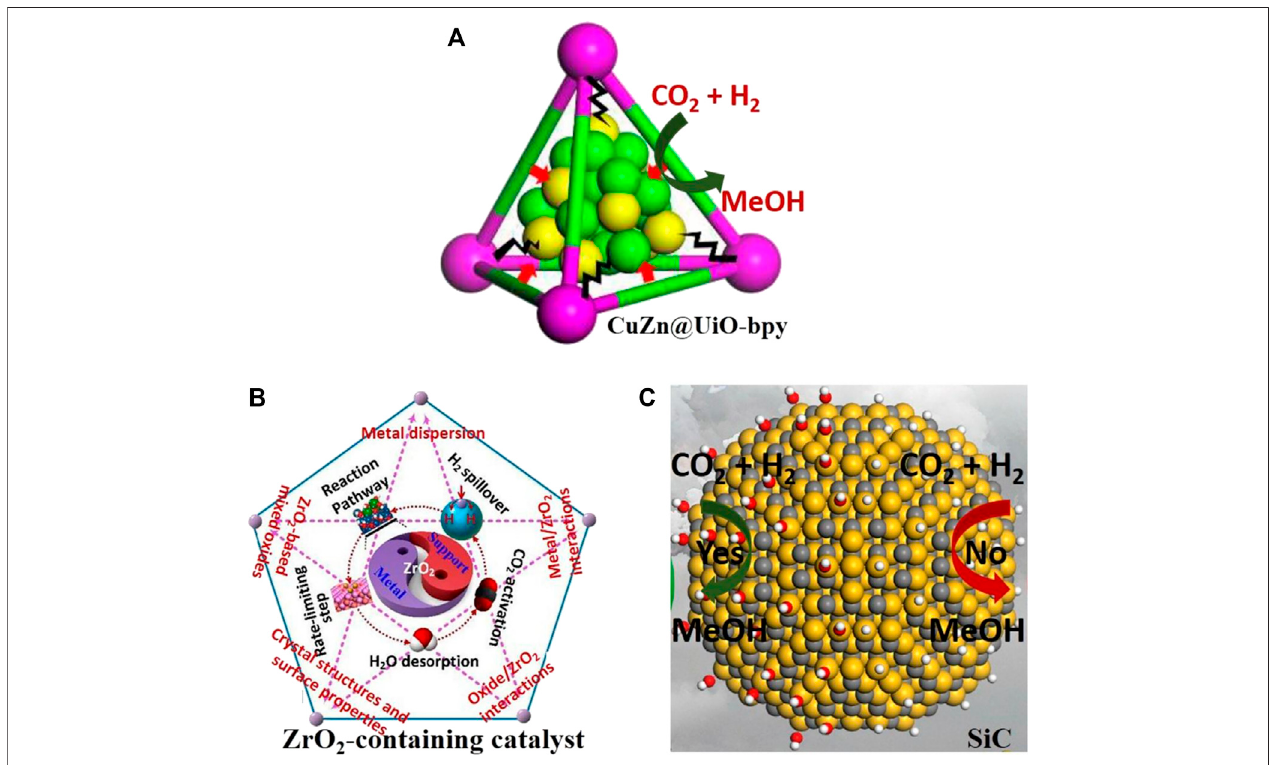
FIGURE 9 | (A) CuZn@UiO-bpy for selective methanol synthesis from CO 2 hydrogenation (An et al., 2017). (B) CO 2 hydrogenation to methanol over ZrO 2 - containing catalysts (Li and Chen, 2019). (C) Hydroxyl groups of SiC surface boosting catalytic activity in CO 2 hydrogenation into methanol (Peng et al., 2018).